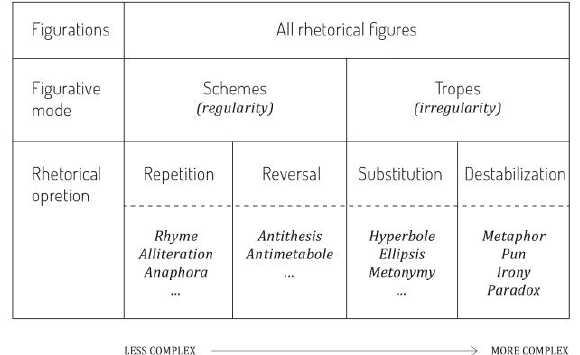
Figure 2. Examples of rhetorical figures applied to typeface design (Hanno & Lupton, 1988). Anaphora (involves repetition of an element or series of elements at the beginning of a se- quence) and anastrophe (inverts normal grammatical order) fall under schematic devices which have more regularity in their representation. Metaphor (an implied comparison be- tween two unlike objects that have some structural similarity) and metonymy (represents one term with another which is close to it in time, space, or causation) fall under tropic devices which are more